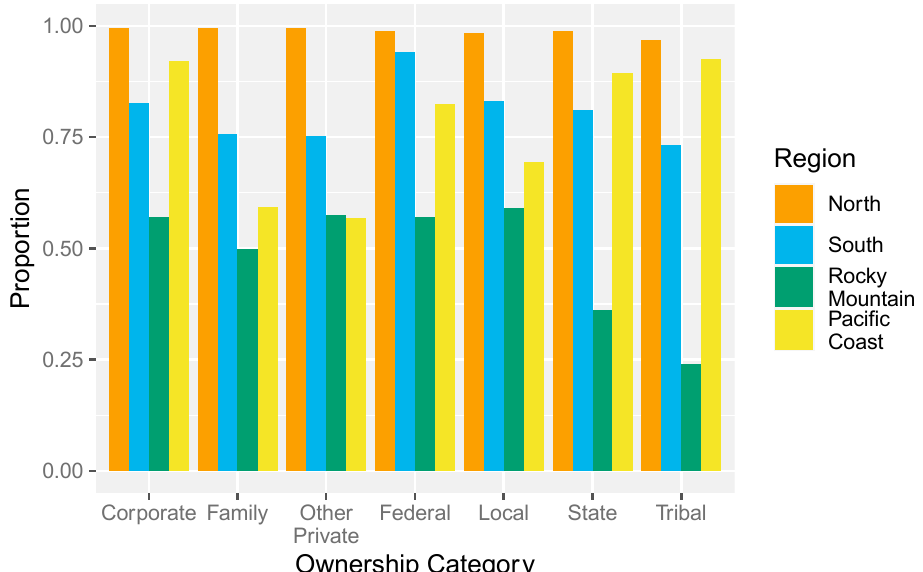
Figure 6. Proportion of forestland that is productive (i.e., ≥ 1.4 m 3 ha − 1 year − 1 ) by ownership category and region, conterminous USA, 2019. Data source: US Department of Agriculture, Forest Service, Forest Inventory and Analysis [20].